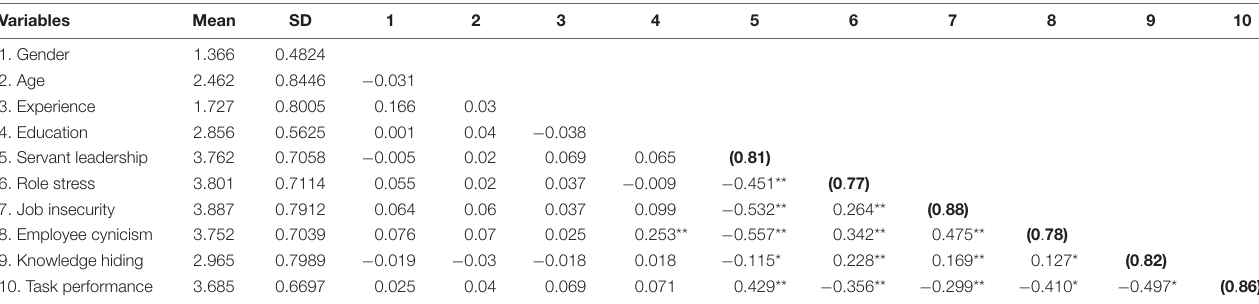
TABLE 1 | Mean, SD, correlations and reliability. Variables